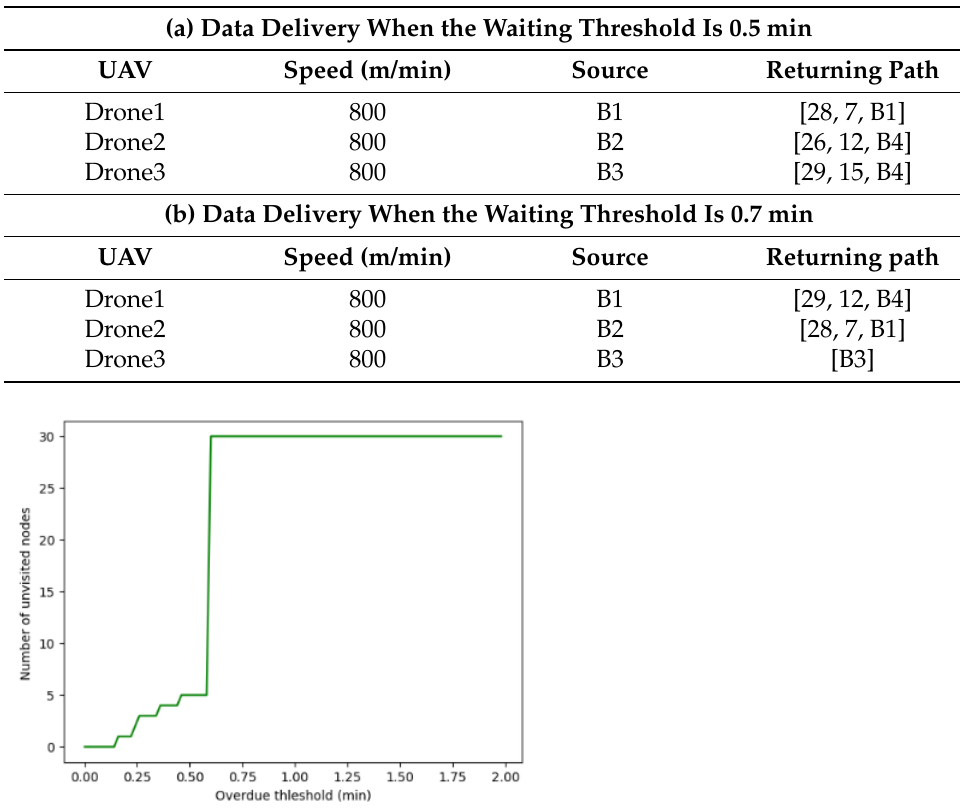
Table 9. Data delivery when the waiting threshold is high.